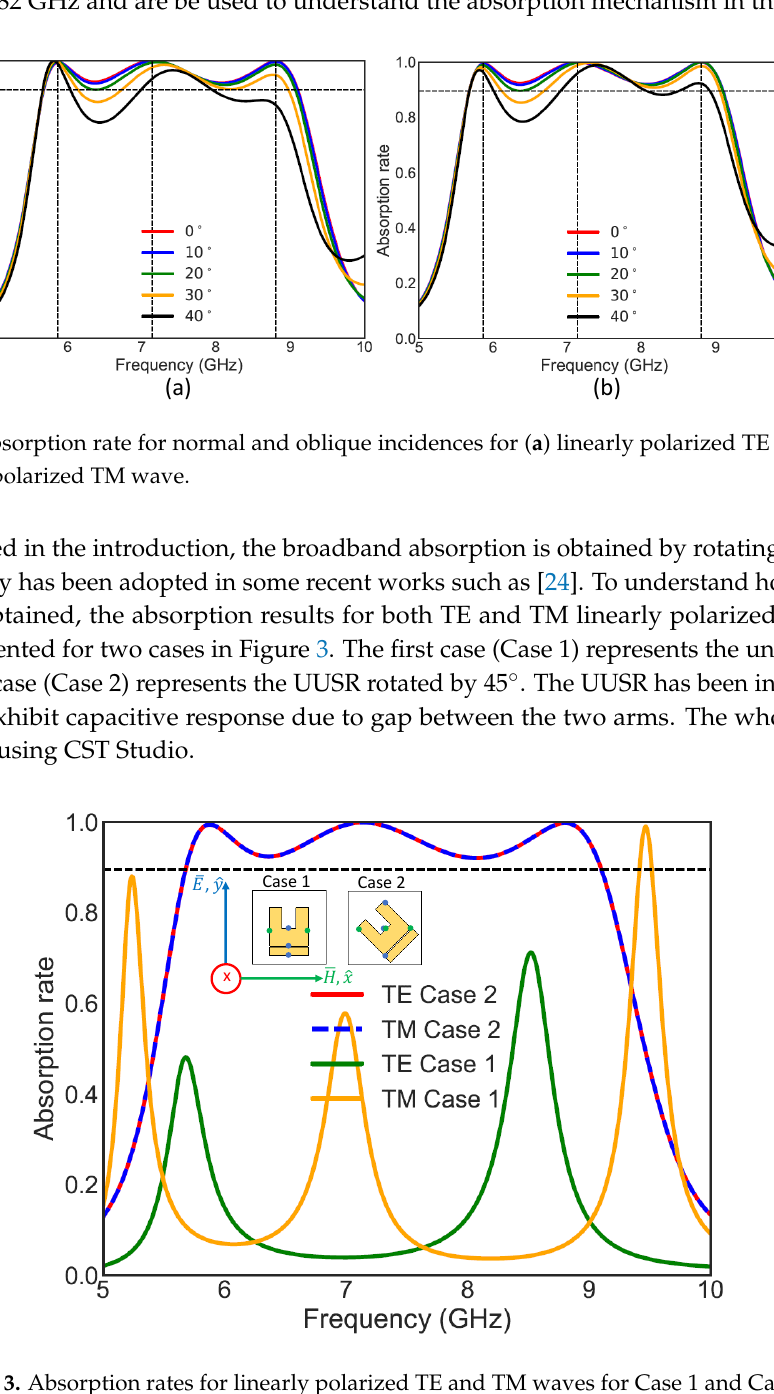
Figure 3. Absorption rates for linearly polarized TE and TM waves for Case 1 and Case